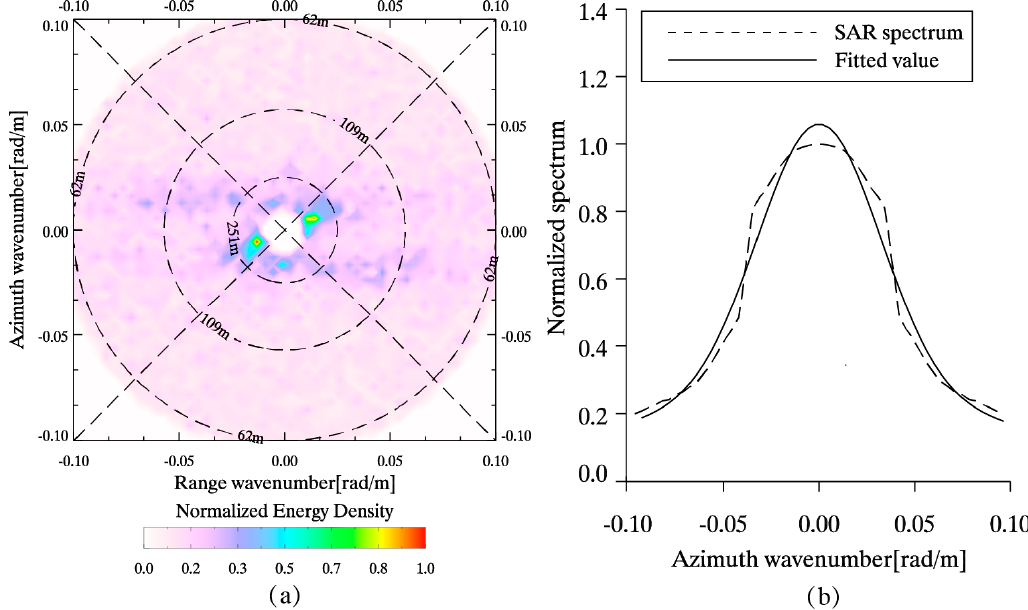
Figure 5. ( a ) The two-dimensional SAR spectrum of sub-scene covering the buoy (ID:46013) in Figure 3; ( b ) The corresponding one-dimensional spectrum with the fitted result by using Gaussian fit function.